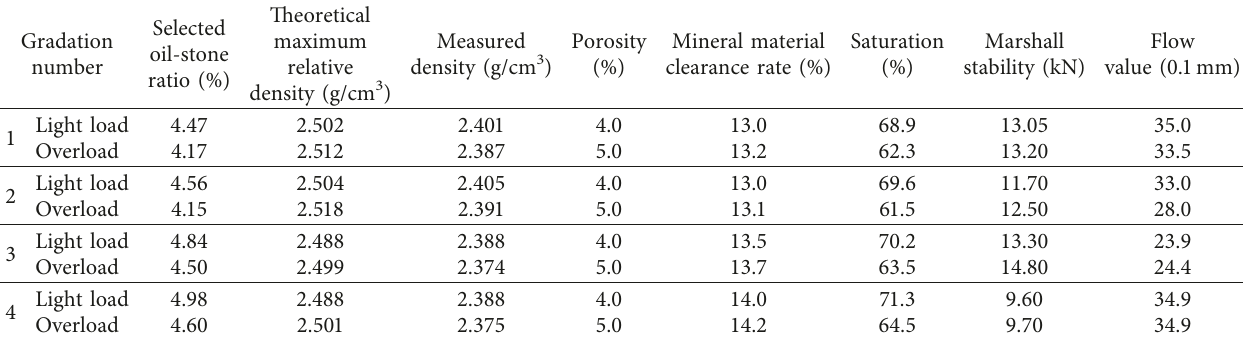
Table 4: Summary of the oil-stone ratios for asphalt mixtures selected using the Marshall method.